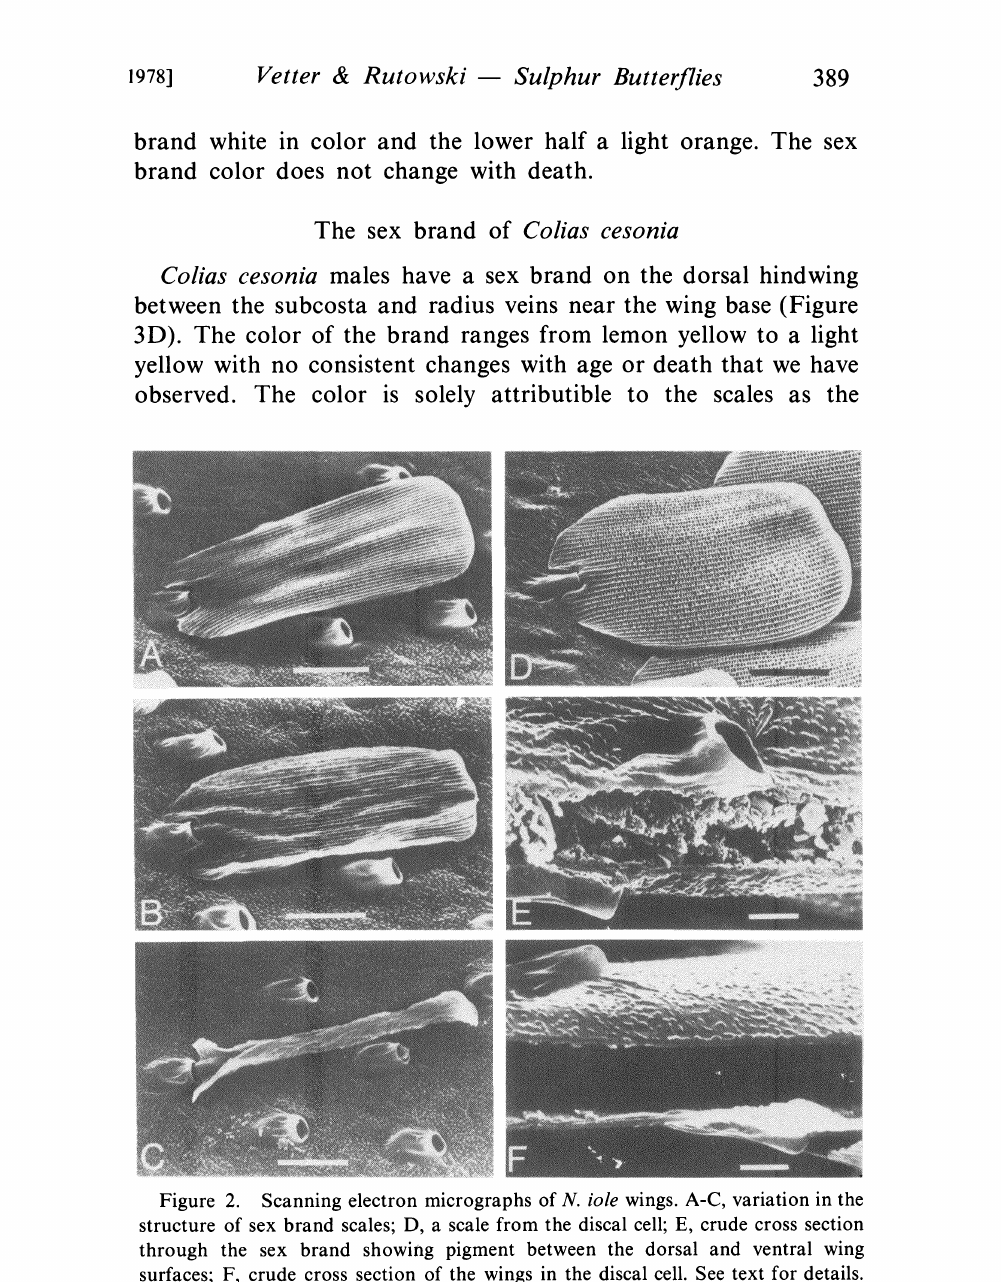
Figure 2. Scanning electron micrographs of N. iole wings. A-C, variation in the structure of sex brand scales; D, a scale from the discal cell; E, crude cross section through the sex brand showing pigment between the dorsal and ventral wing surfaces; F, crude cross section of the wings in the discal cell. See text for details. Scale lines: A-D, 20#; E and F,